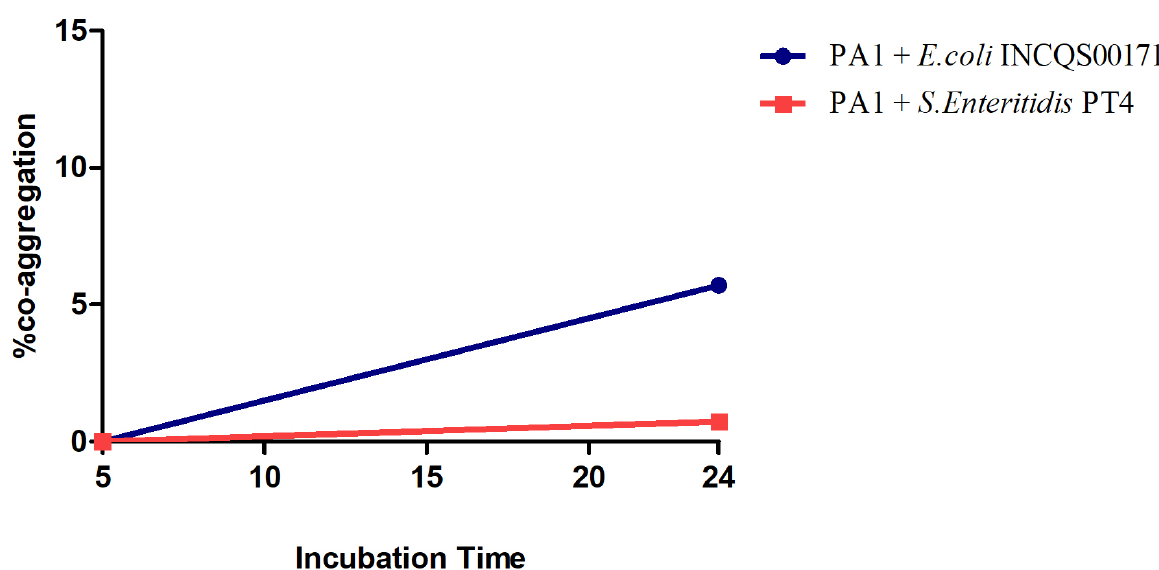
Figure 4. Co-aggregation of Lactiplantibacillus plantarum A1 after 24 hours of incubation. The percentage of co- aggregation of PA1 increased to 5.7% with E.coli and to 0.7% with S. Enteridis